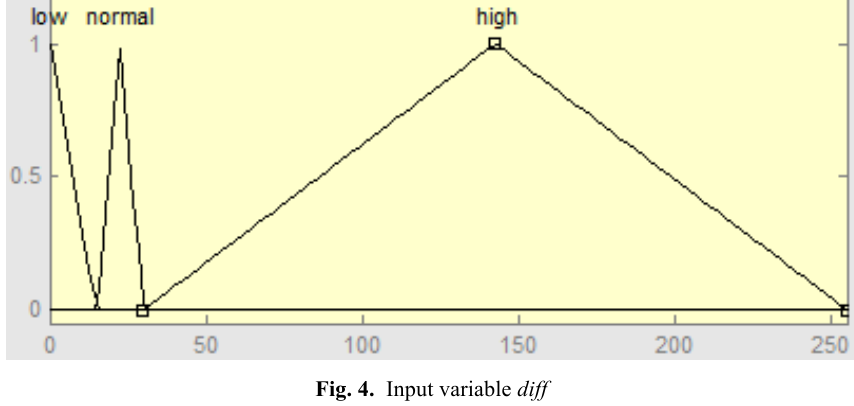
Fig. 4. Input variable diff